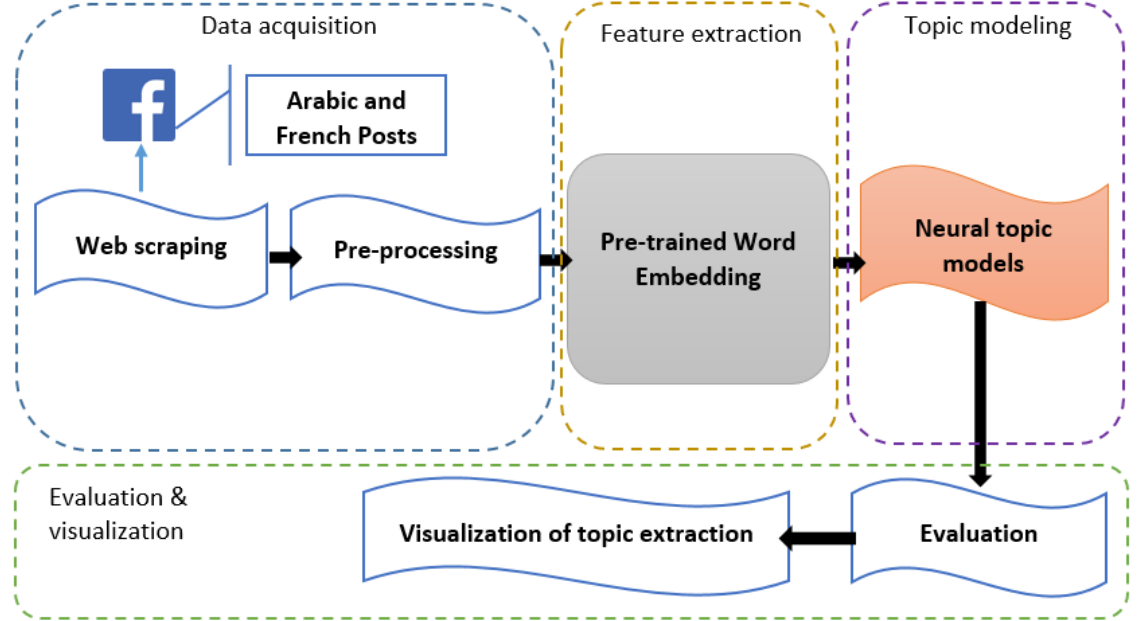
Figure 1. The global architecture.